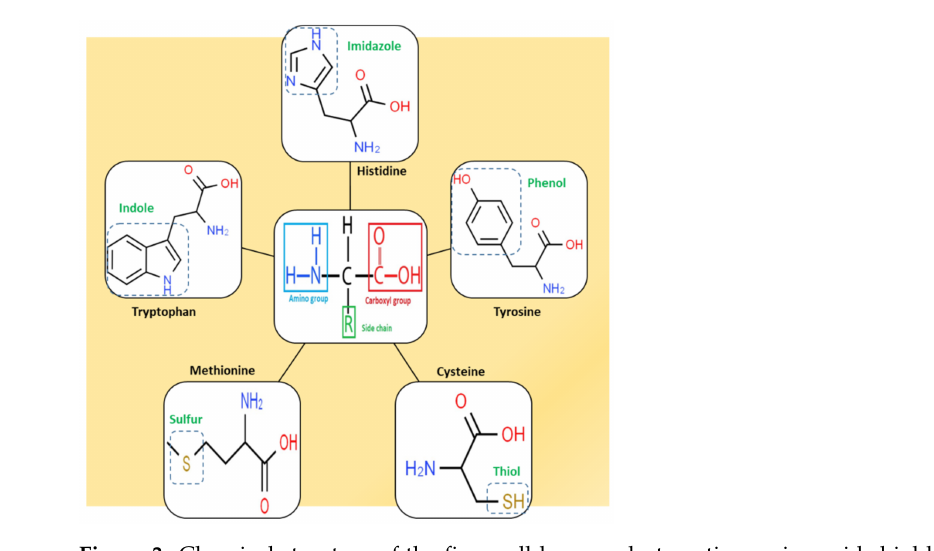
Figure 3. Chemical structure of the five well-known electroactive amino acids highlighting their electroactive side chain.